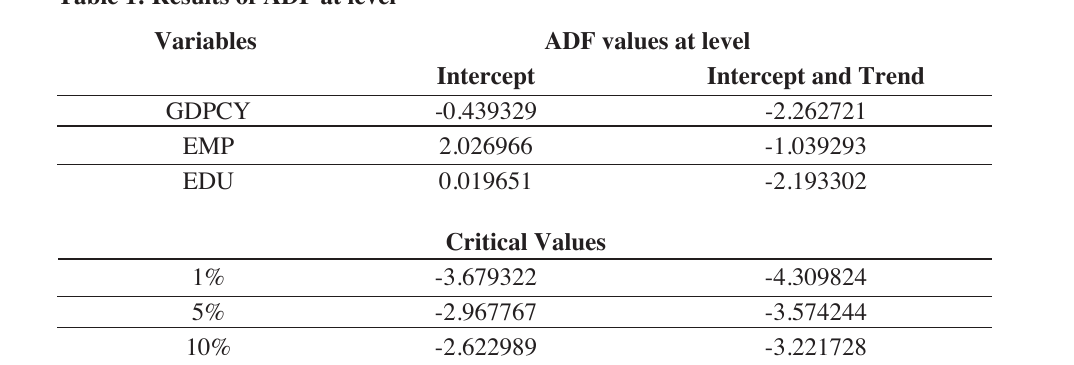
Table 1: Results of ADF at level